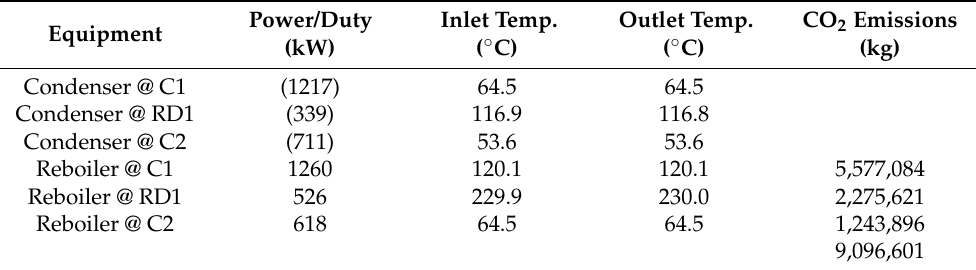
Table 5. Hot and cold stream data for the conventional process for PGMEA production.